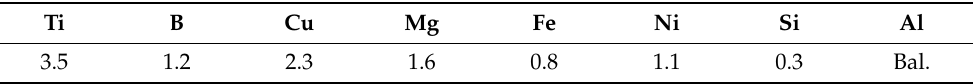
Table 1. Chemical composition (wt.%) of the pre-alloyed 2618 Al alloy modified with Ti and B. Ti B Cu